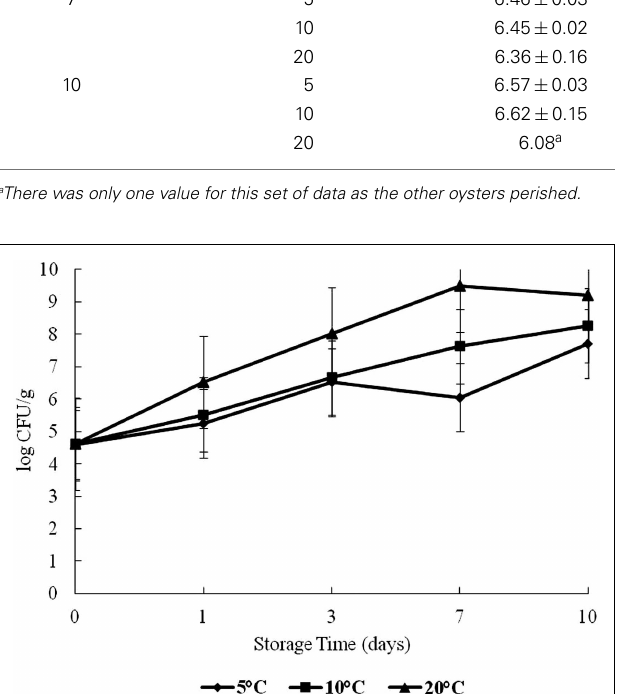
Vp levels increased significantly ( p < 0.05) over time with